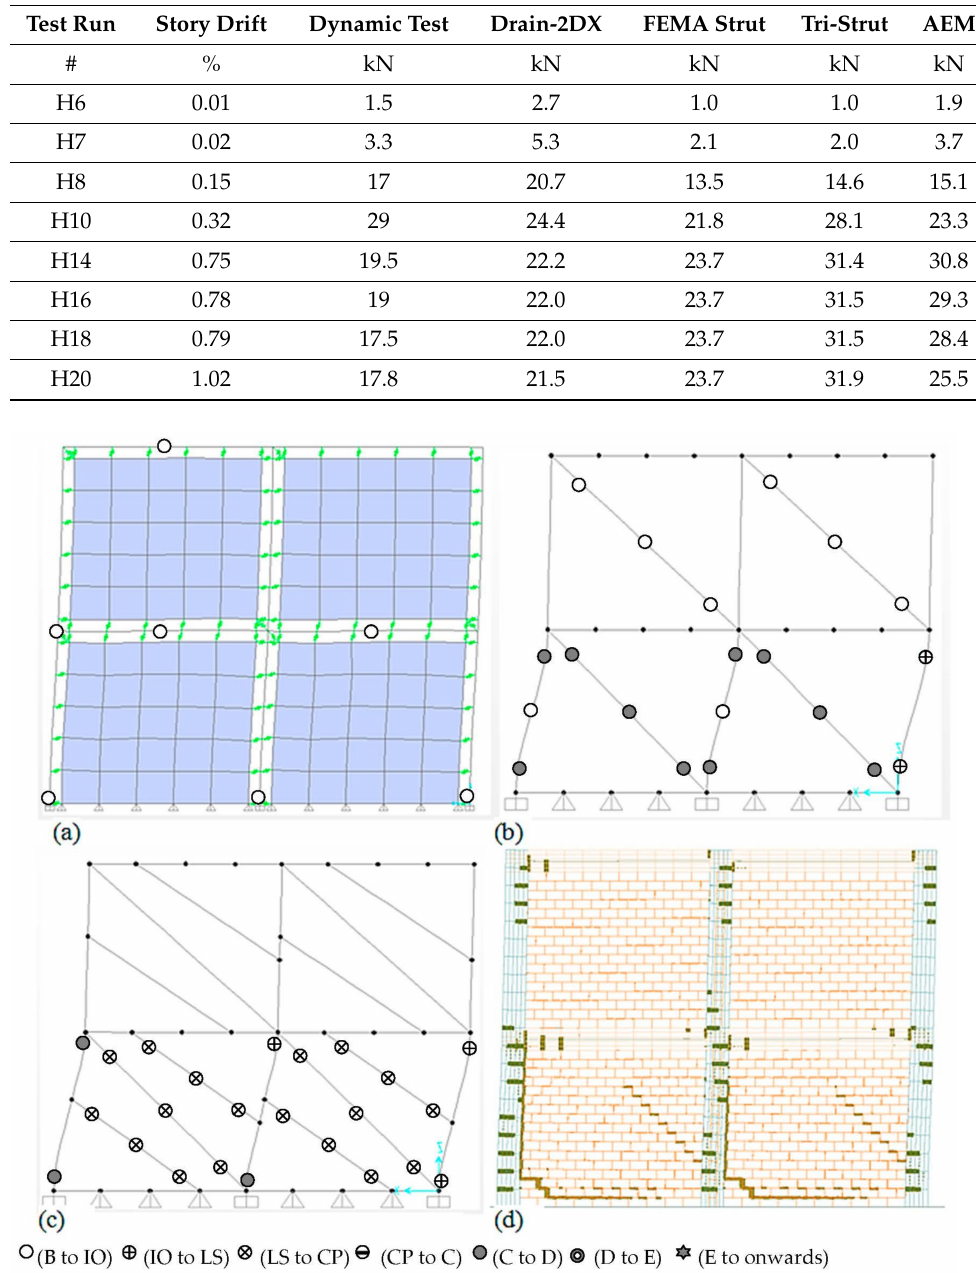
Figure 14. Comparison of predicted damage profiles; ( a ) Homogenous Shell Model; ( b ) FEMA strut model; ( c ) Tri-strut model; ( d )